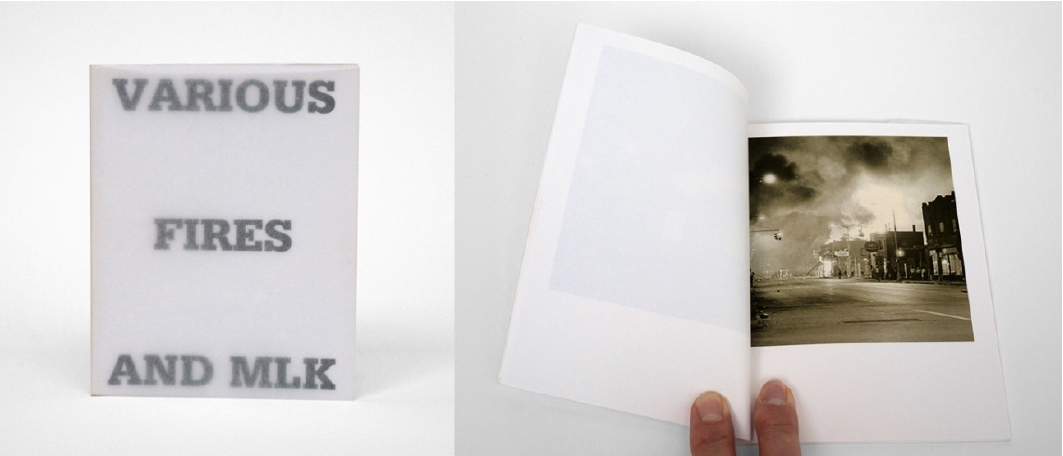
Figure 11. Scott McCarney, Various Fires and MLK , 2010.